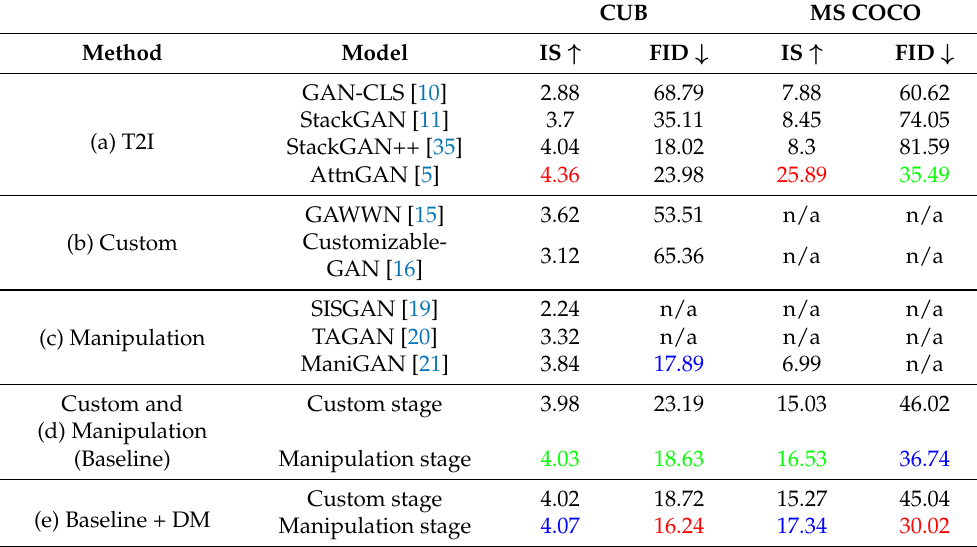
Table 2. The quantitative comparison results among the T2I methods (a), custom methods (b), manip- ulation methods (c), and our method (d,e) are shown